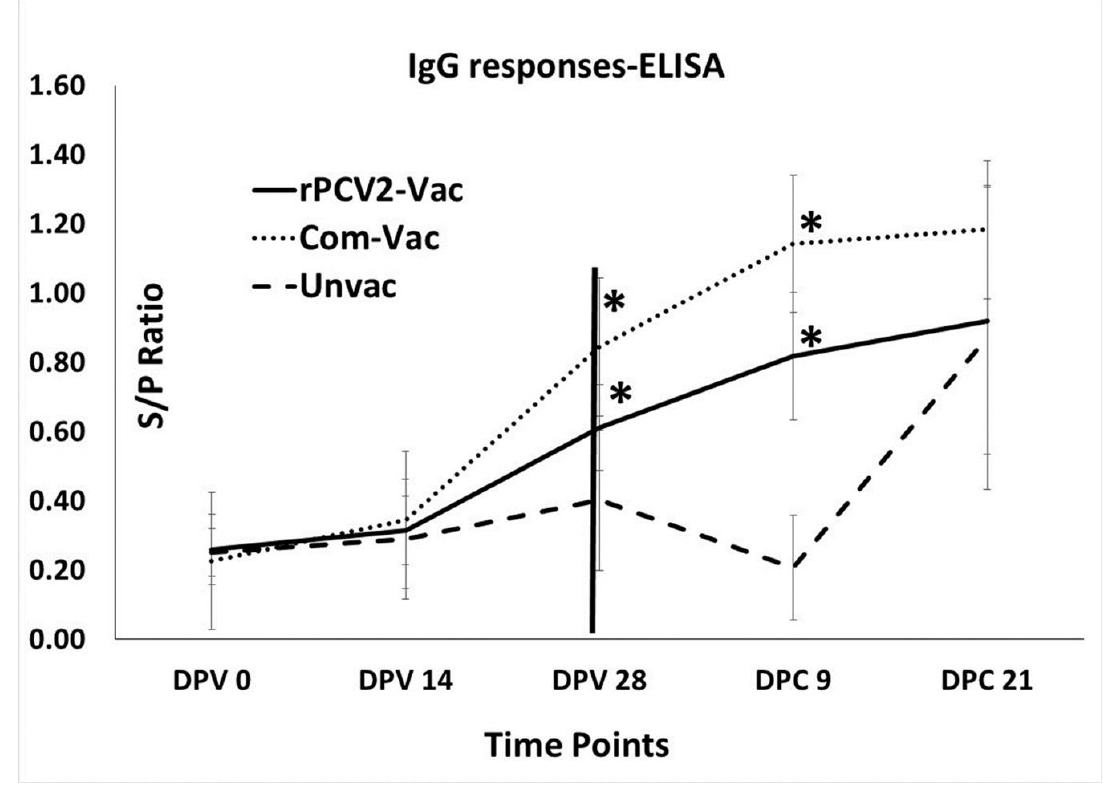
Figure 3. Anti-PCV2 IgG responses: Mean signal to positive (S/P) ratios of sera collected on days 0, 14 and 28 post vaccination (DPV) and on days 9- and 21-days post-challenge (DPC), as measured by a PCV2 specific commercial ELISA. X axis: time points of serum collection, Y axis: sample to positive (S/P) ratio, dotted line: commercial vaccine, solid line: rPCV2-Vac, dashed line: unvaccinated. Error bars indicate the standard deviation, * significantly different from the unvaccinated control, p ≤ 0.05, Students t test. Significant differences were not detected between the rPCV2-Vac and commercial vaccine.